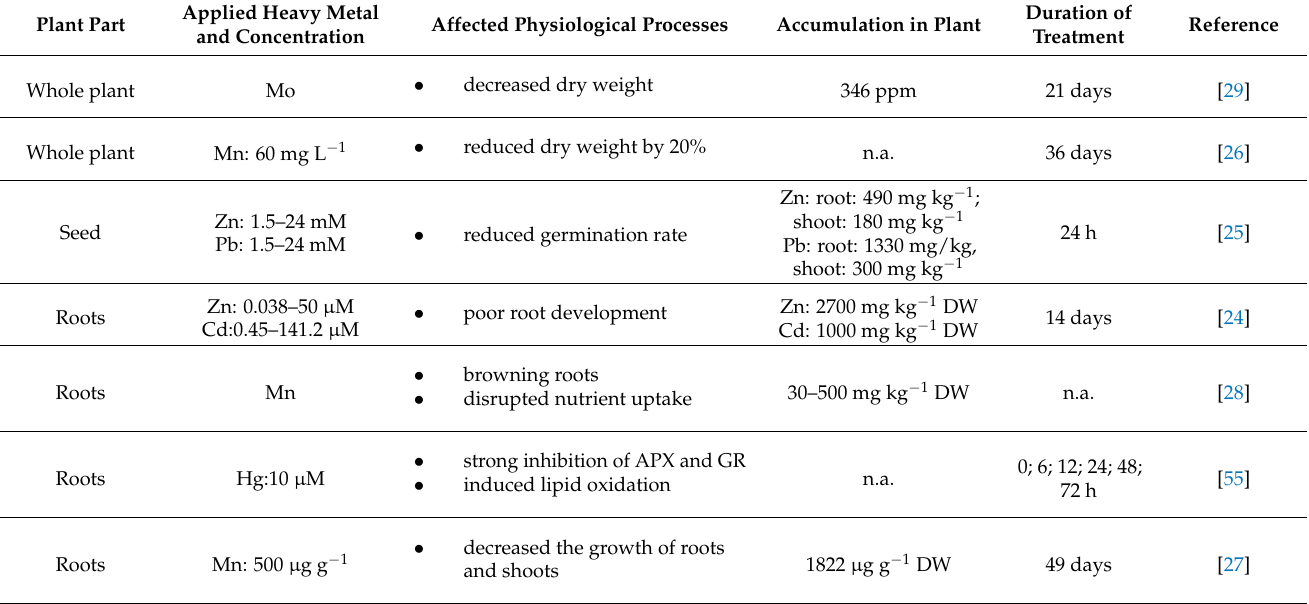
Table 1. Plant part, applied heavy metal and concentration, affected physiological processes, accumu- lation in the plant, and the duration of treatment of HM-treated alfalfa